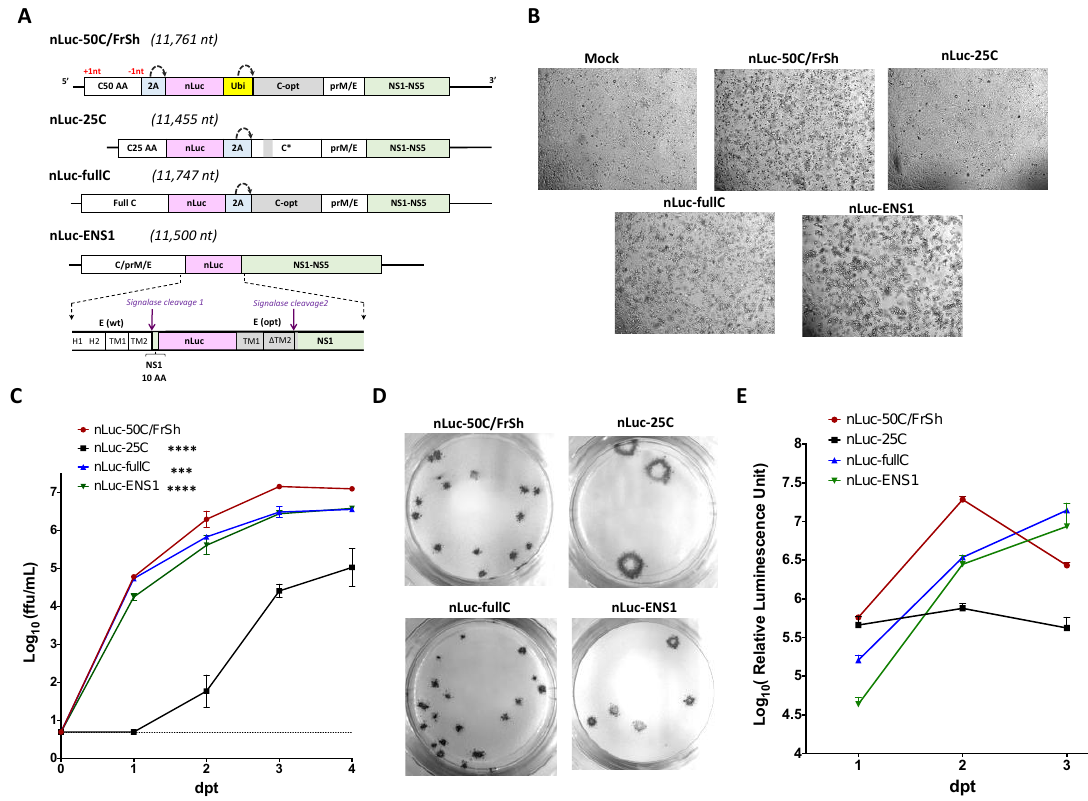
Figure 3. Construction and characterization of nLuc-carrying viruses in Vero cells. ( A ) Genetic organization of nLuc-containing viruses. ORF shifting and restoring mutations are highlighted as + 1nt and − 1nt, respectively. 2A: 2A protease sequence from FMDV; Ubi: ubiquitin sequence; gray boxes highlight codon-optimized sequences in the C and E genes of ZIKV. C* in nLuc-25C is a C opt gene with mutations in 14–17 AA codons. Dotted arrows represent the sites of cleavage by 2A protease or ubiquitin. ( B ) Microscopic evaluation (at 40 × magnification) of CPE in Vero cells monolayer observed on day 6 after plasmid DNA transfection (dpt). ( C ) Growth kinetics of nLuc-carrying viruses in Vero cells after plasmid DNA transfection. Mean virus titer ± standard deviations in the samples that were collected daily from duplicate flasks was determined by titration on Vero cells. Dotted line represents limit of detection of the FFA (0.7 Log 10 ( ff u / mL)). Di ff erences between growth kinetics of nLuc-50C / FrSh and those of the other three constructs were compared using two-way ANOVA (**** p < 0.0001; *** p < 0.001). ( D ) Plaque morphology of nLuc-carrying viruses in Vero cell monolayer as revealed by immunostaining at 5 dpi. ( E ) Kinetics of luciferase activity following plasmid DNA transfection into Vero